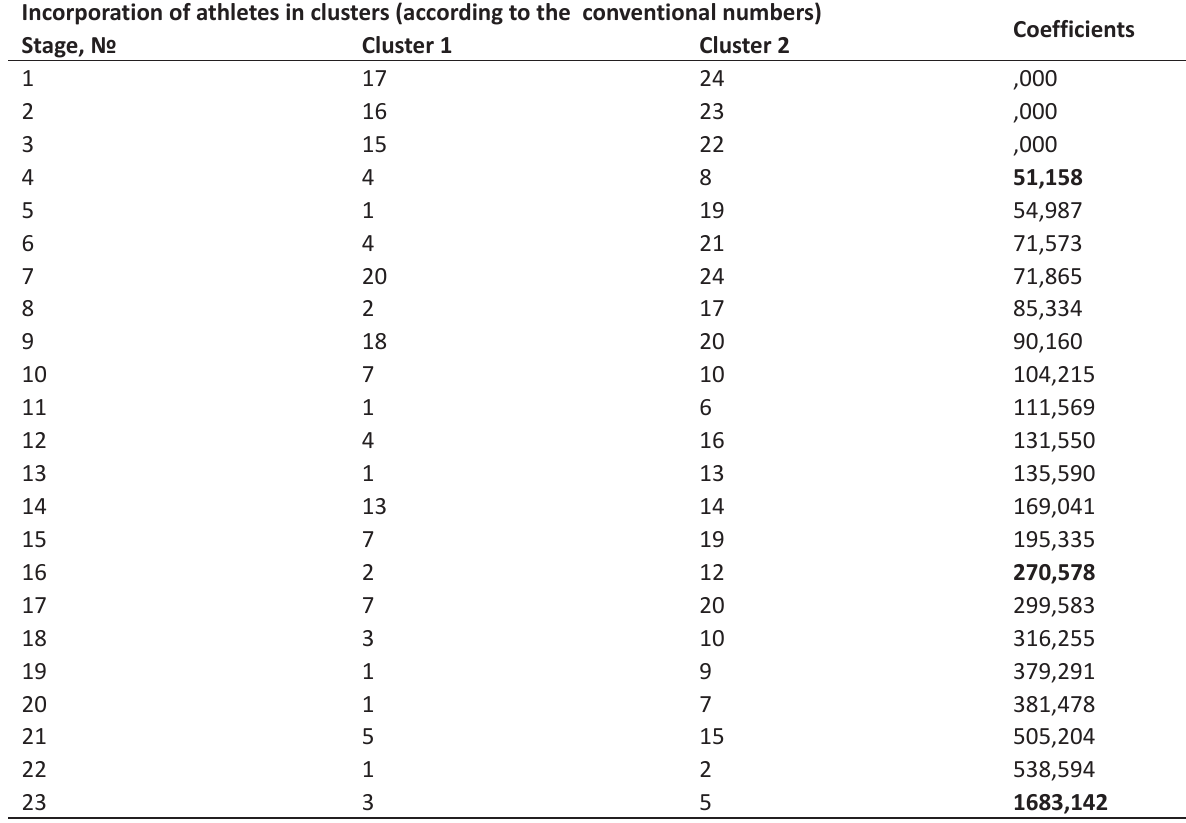
Table 1. The agglomeration order in cluster analysis of psycho-physiological testing indicators of athletes (n=24) Incorporation of athletes in clusters (according to the conventional